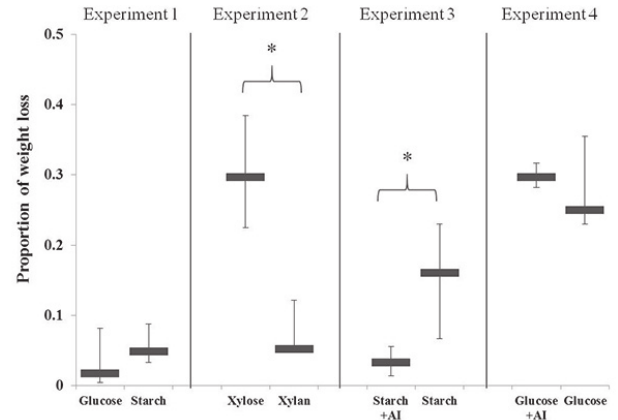
Fig 1. Median and quartiles of the percent weight loss of artificial food over a 14 day period due to termite feeding (adjusted for natural water loss from each food square) for all four experiments in this study. The four experiments were analyzed independently. An asterisk indicates a significant difference between percent weight loss (p <0.03) of the two food types in the